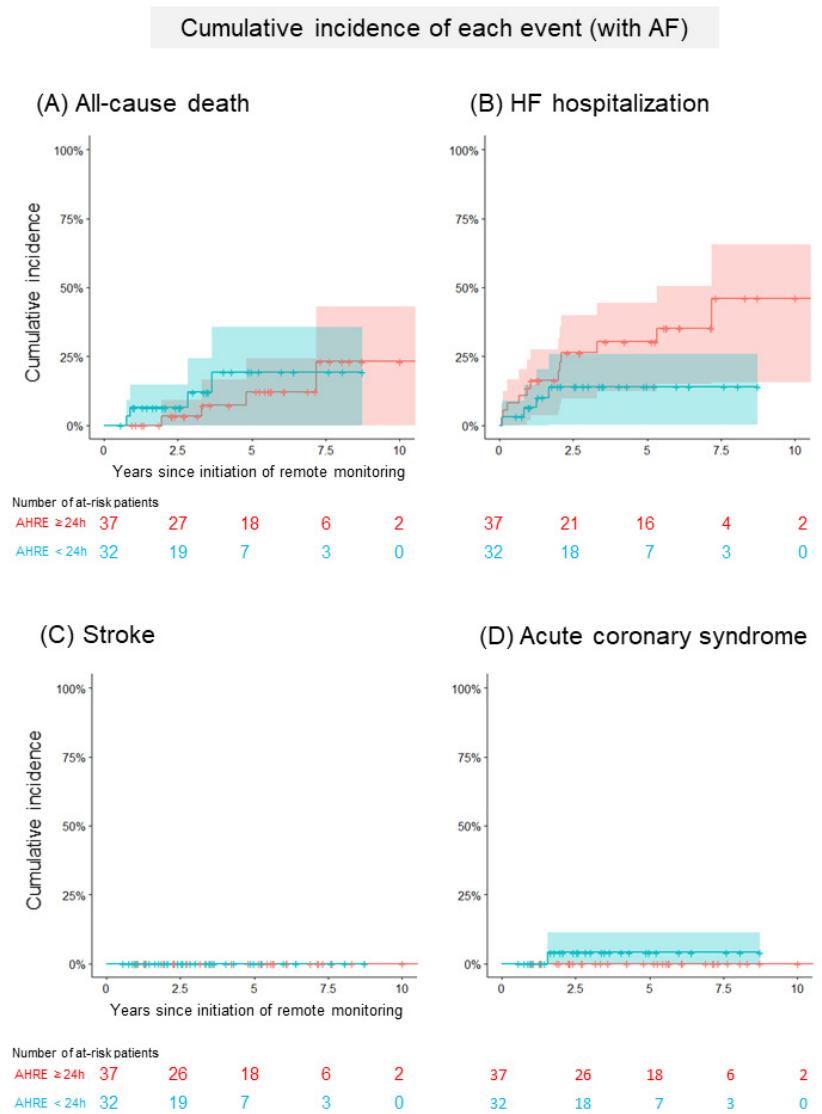
Figure 4. Comparison of the cumulative incidence of each event in patients with a history of AF. ( A ) The Kaplan–Meier curve shows the cumulative incidence and 95% CI of all-cause deaths following the initiation of remote monitoring in patients with a history of AF (red: patients with AHRE ≥ 24 h, blue: <24 h). ( B ) The Kaplan–Meier curve shows the cumulative incidence and 95% CI of heart failure hospitalizations following the initiation of remote monitoring in patients with a history of AF (red: patients with AHRE ≥ 24 h, blue: <24 h). ( C ) The Kaplan–Meier curve shows the cumulative